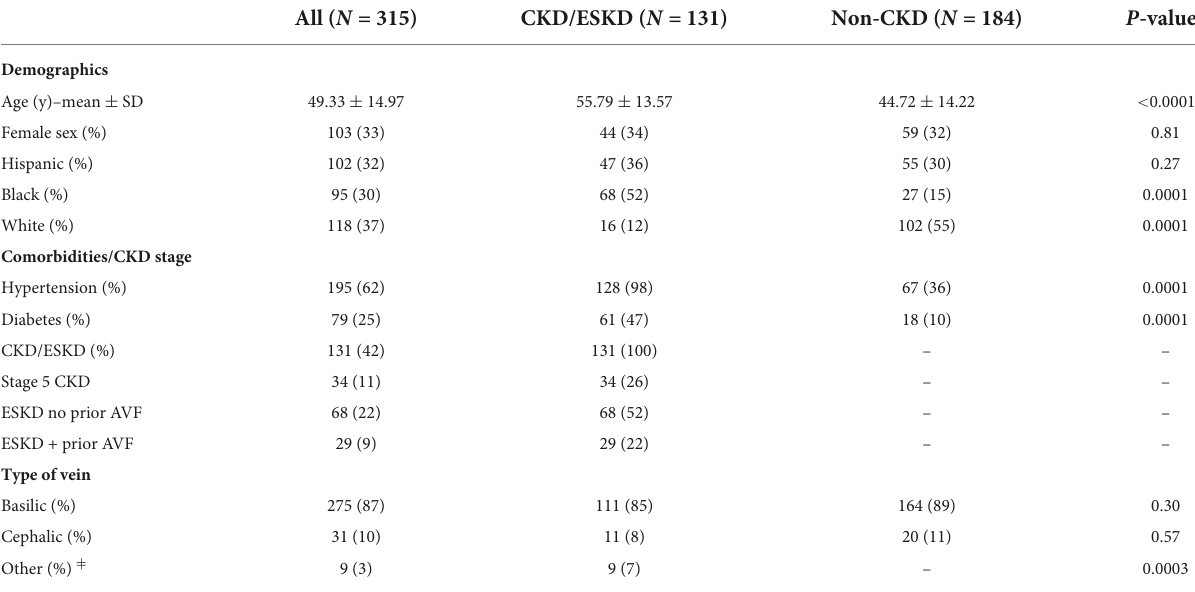
TABLE 1 Baseline characteristics of the study cohorts.